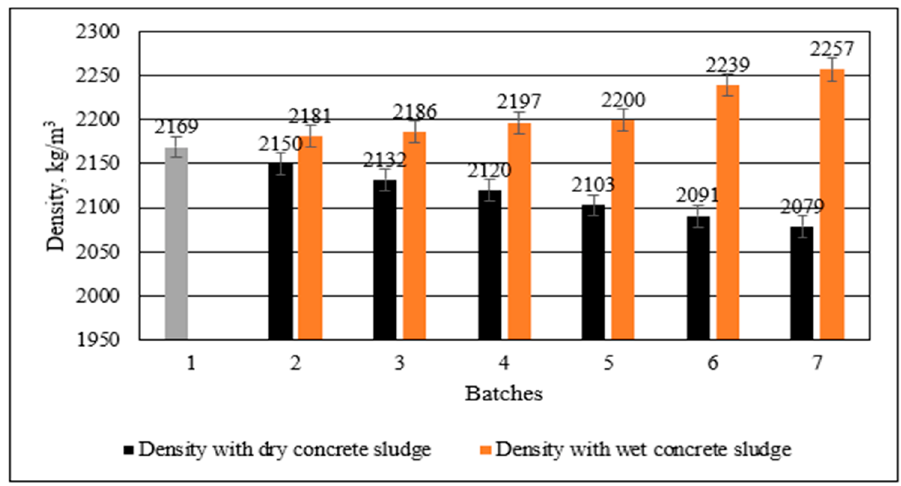
Figure 9. Density of concrete with different amounts of cement replaced with wet and dry concrete sludge.